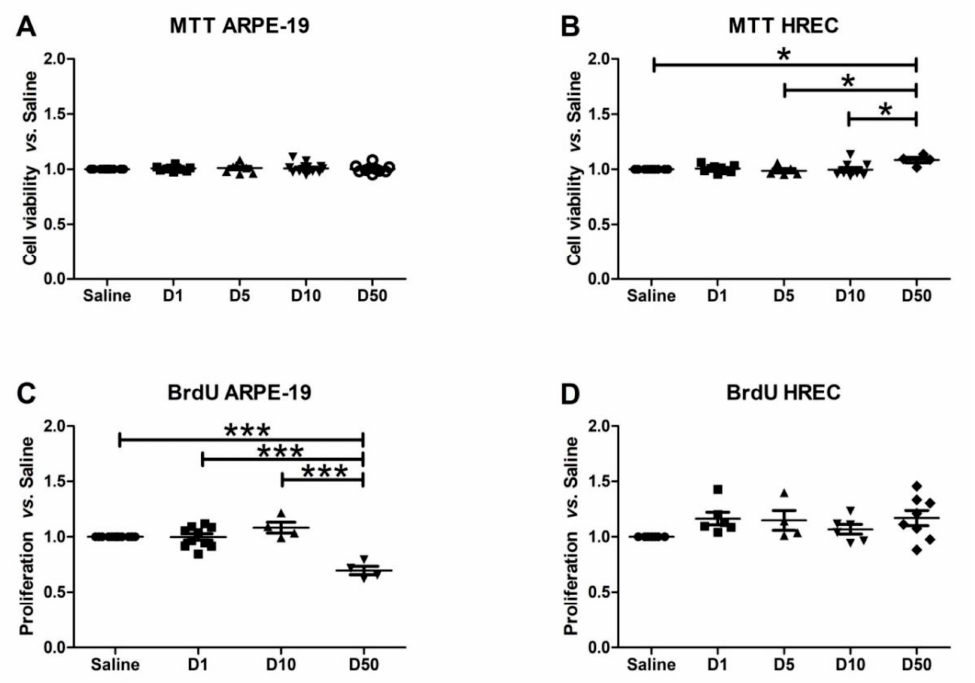
Figure 3. Graphs showing 3-(4,5-dimethylthiazol-2-yl)-2,5-diphenyltetrazolium bromide (MTT) ( A , B ) and Bromodeoxyuridine (BrdU) ( C , D ) results for ARPE-19 ( A , C ) and HREC ( B , D ) cells treated with different VITD concentrations (1, 5, 10, and 50 nM) for 1 h. Any VITD dose showed cytotoxic effects